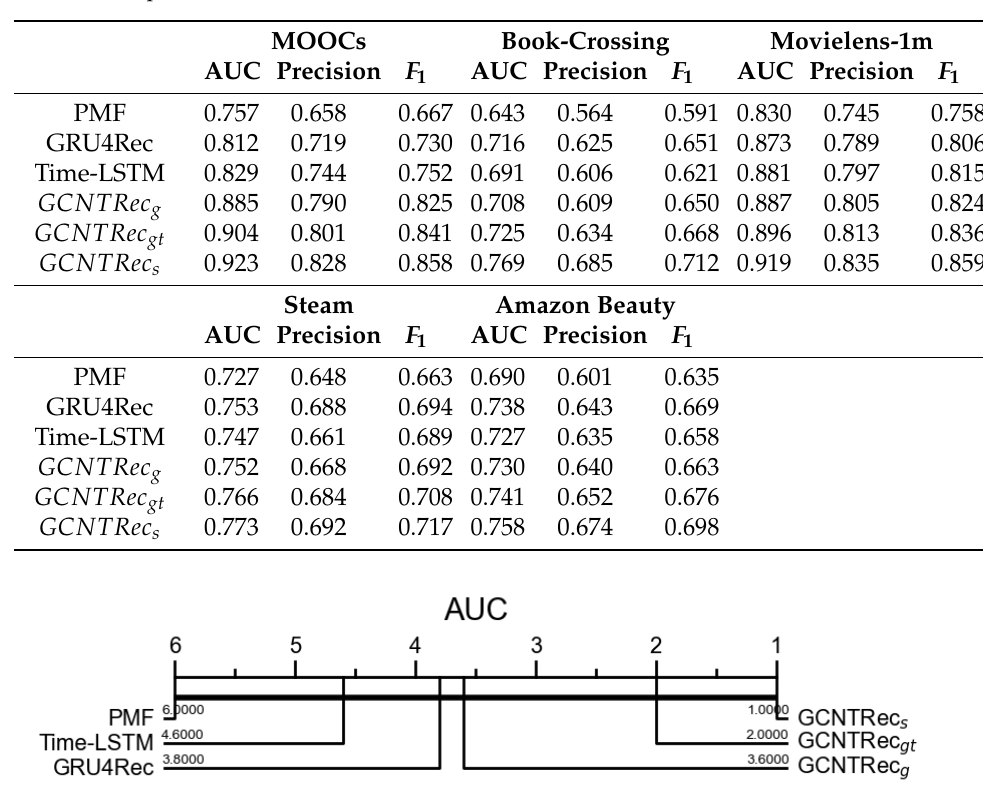
Table 3. Comparison of the results of each model.